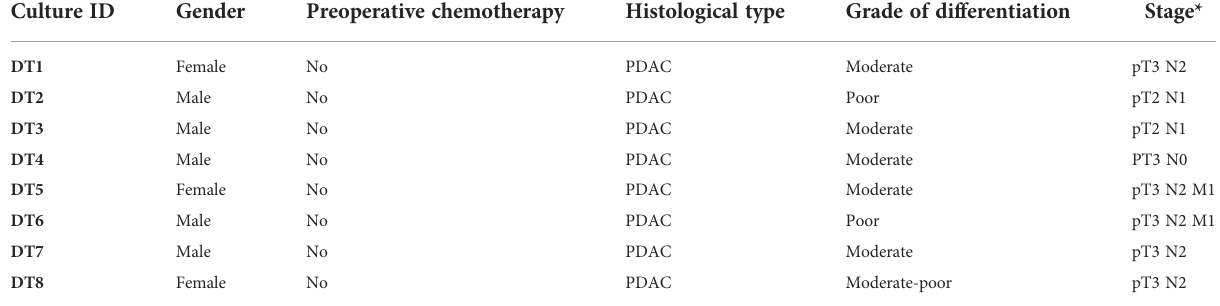
TABLE 1 Clinicopathological